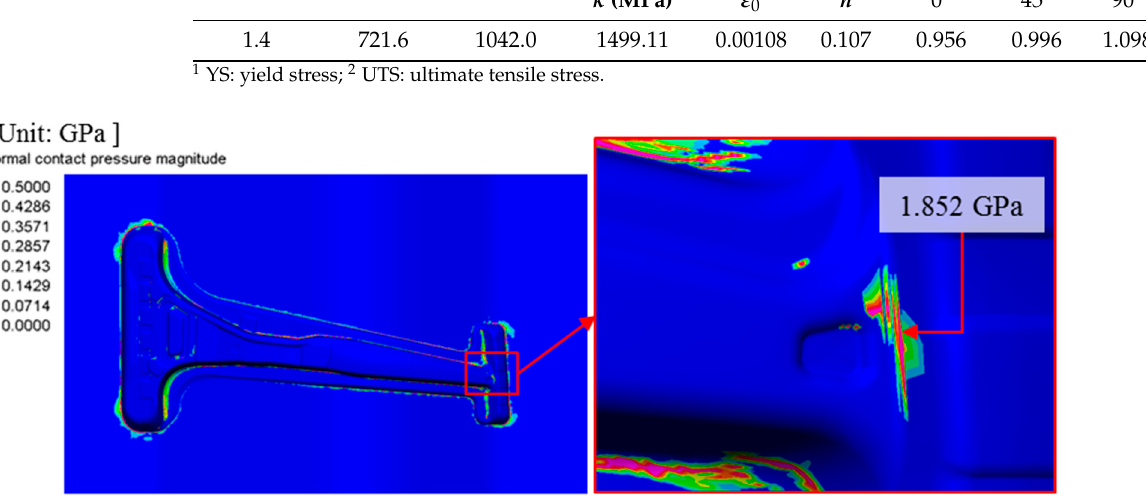
Figure 2. Contact pressure distribution in the stamping simulation of the B-pillar with a DP980 steel sheet.